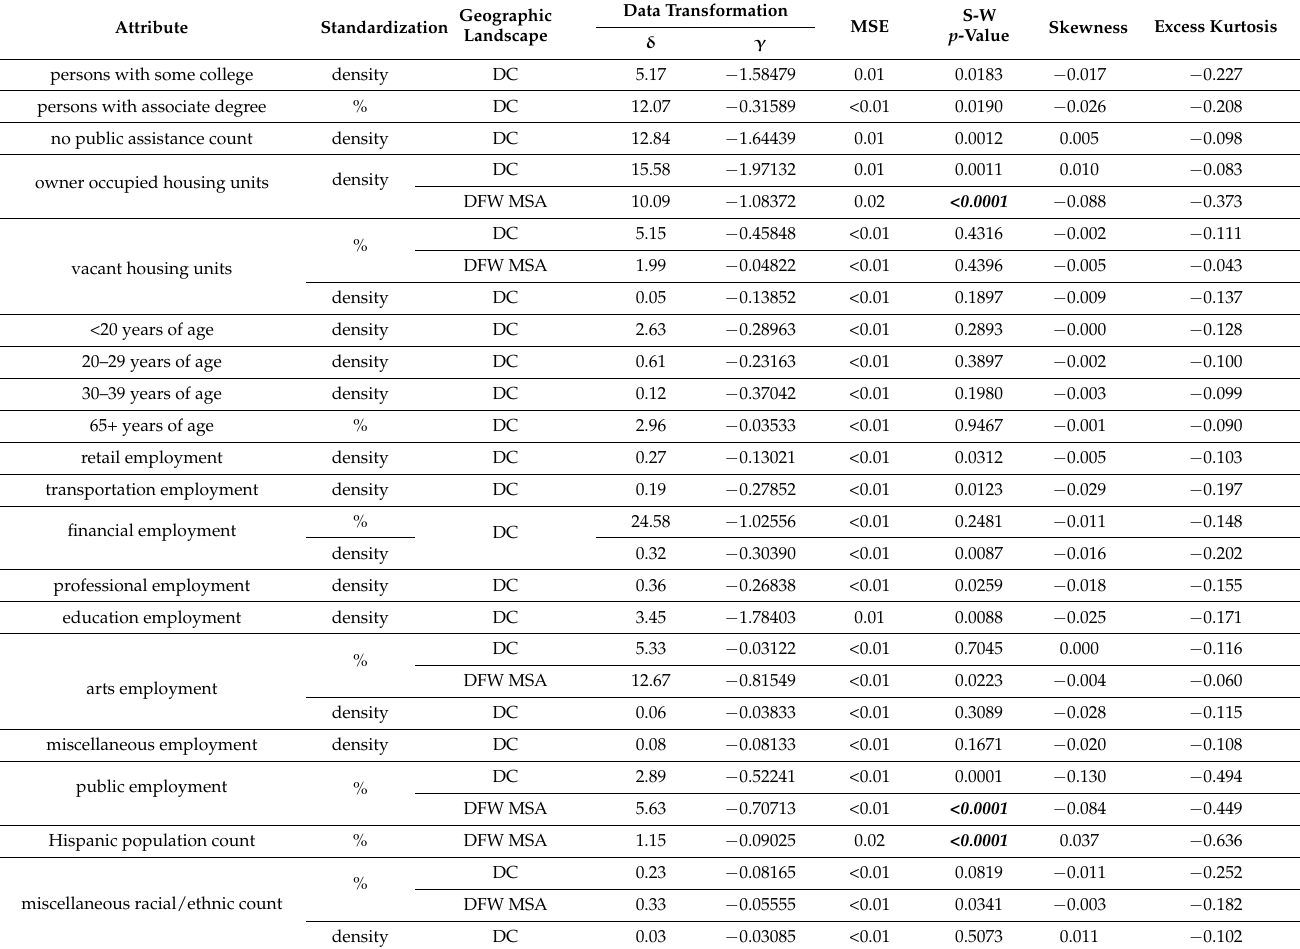
Table A2. Some relevant facets of reciprocal Box–Cox data transformation oriented attribute